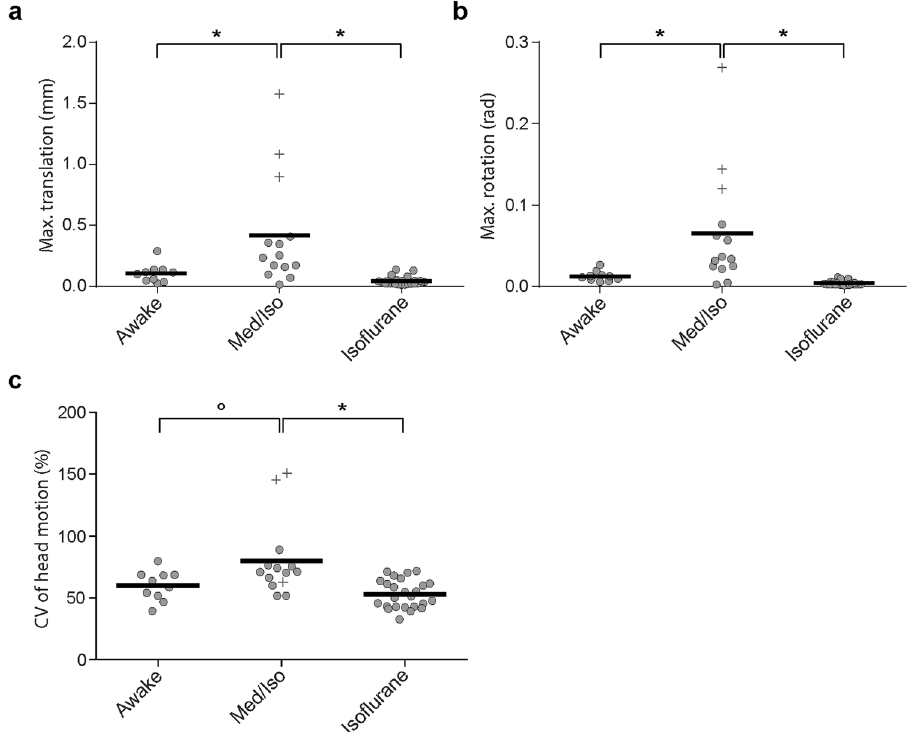
Figure 2. Head motion during fMRI scanning in awake and anaesthetized conditions. The graphs report the maximal head translation ( a ) and rotation ( b ), and the coefficient of variation (CV) of the total head motion over time ( c ) for the fMRI scans of awake birds and birds anaesthetized with a low dose of Med/Iso or isoflurane. Individual measurements are depicted by grey circles and the group mean by the black line. Crosses point to three animals of which the maximal translation was beyond 2 voxel sizes and which were therefore excluded from the subsequent analyses ( * p <